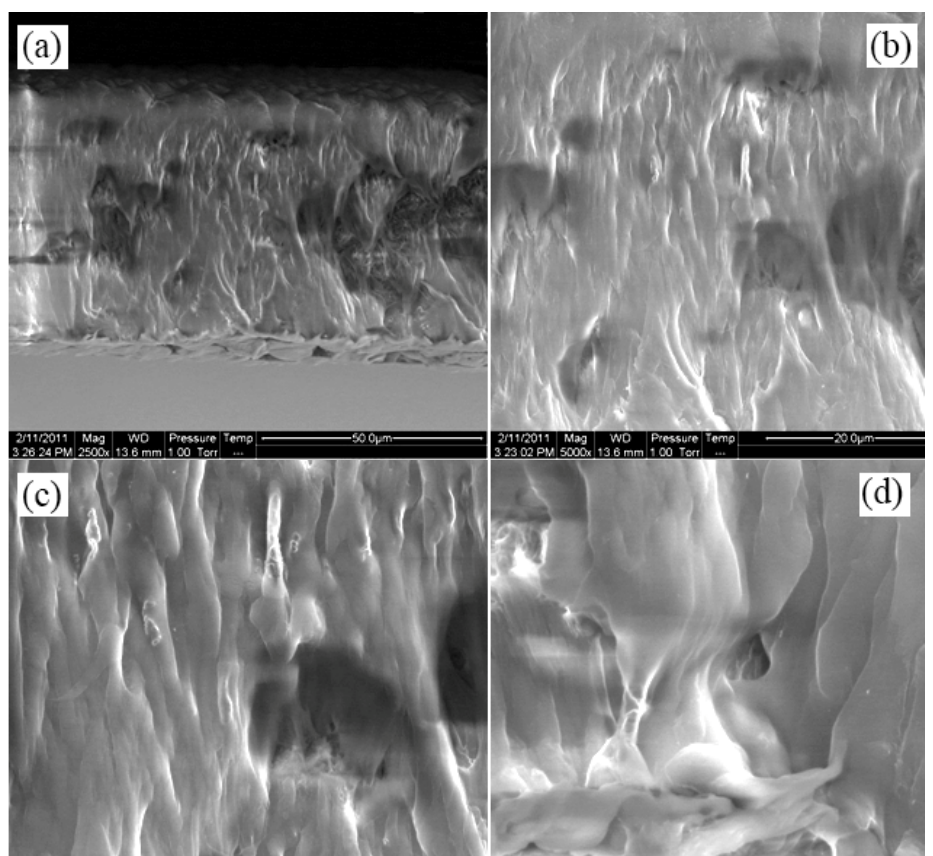
Figure 4. Cross-sectional SEM micrographs of the PA membrane: ( a ) 2500× magnification; ( b ) Vertical channel distribution of PA 46, 5000× magnification; ( c ) and ( d ) Morphology of the pore-wall, 10,000× and 20,000×